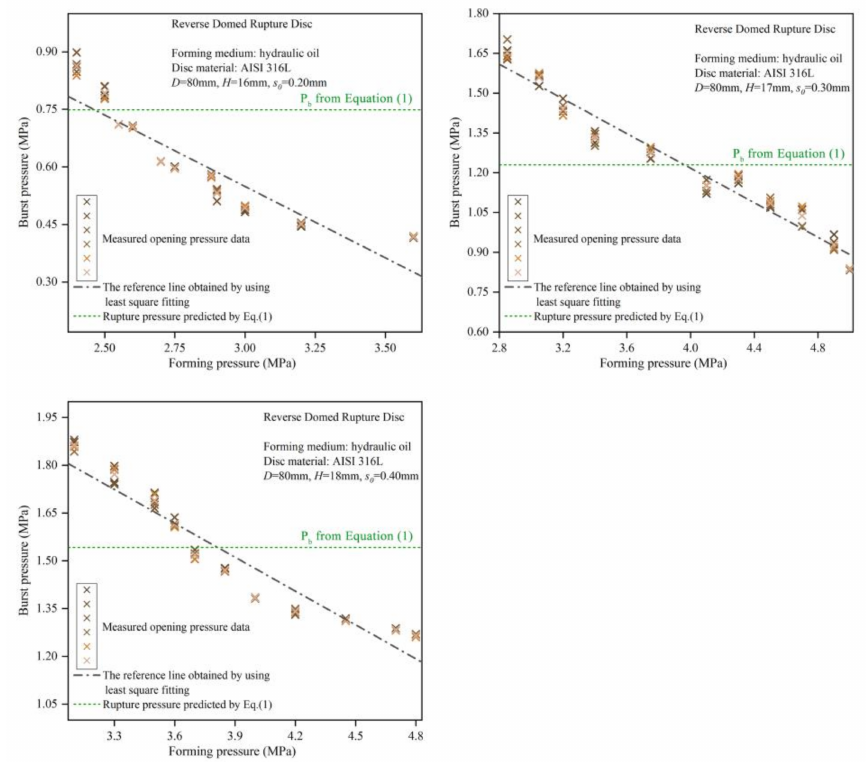
Figure 11. For the hydraulic forming method, the relationship between the burst pressure and the forming pressure of rupture discs with a diameter of 80